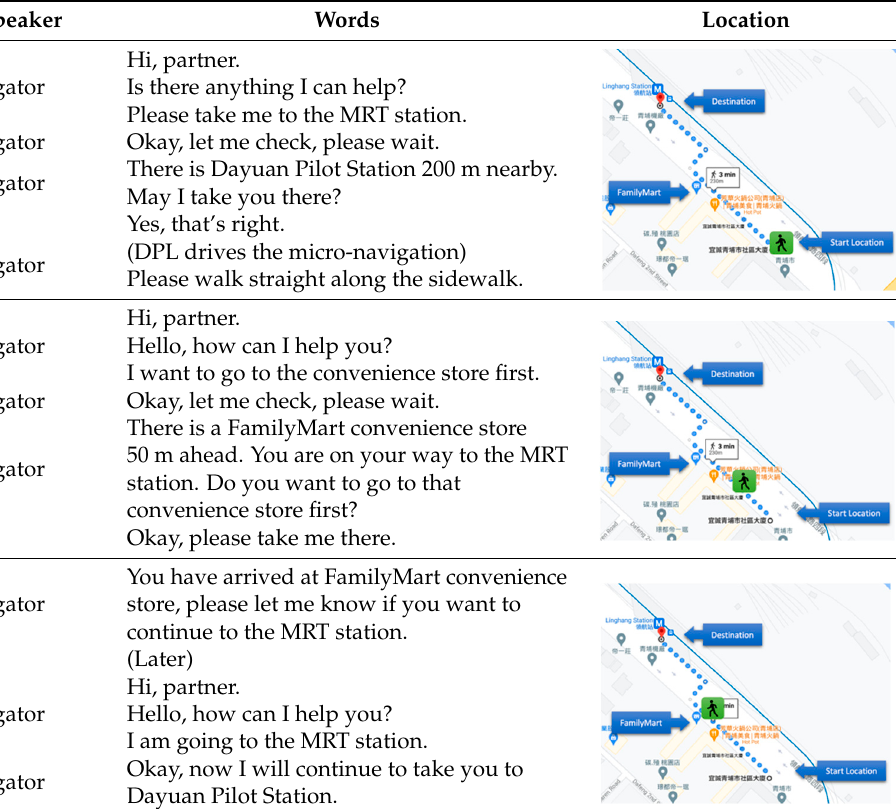
Table 4. The walking route and conversation of the entire navigation.